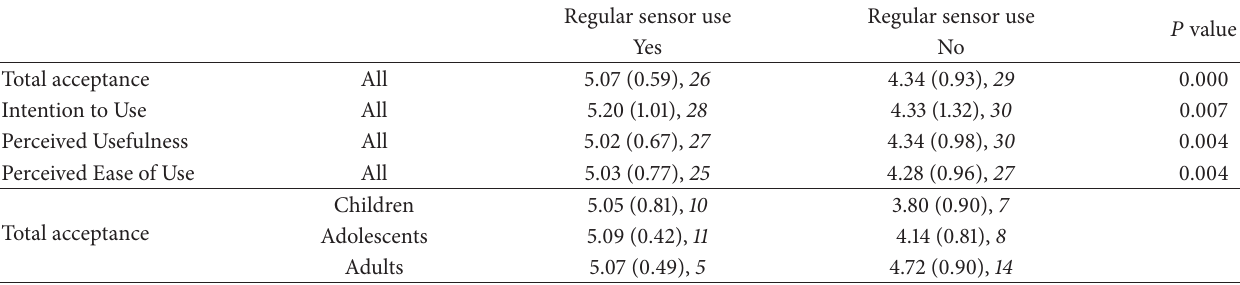
Table 3: Association between acceptance of an artificial pancreas and regular sensor use initial.